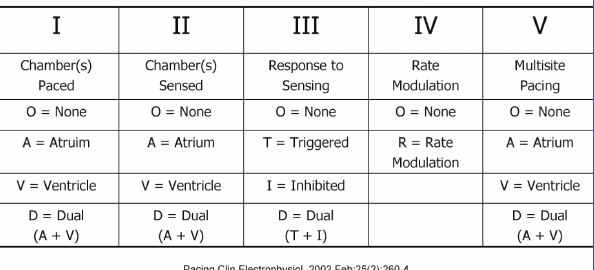
Figure 2: Pacemaker Codes